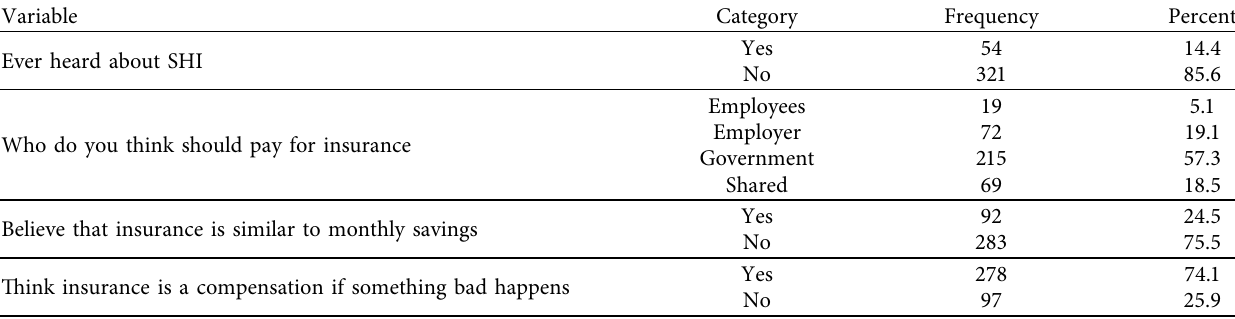
Table 3: Exposure and perception regarding SHI of the government employees in Muja town, northeast Ethiopia, 2016 ( n � 375). Variable